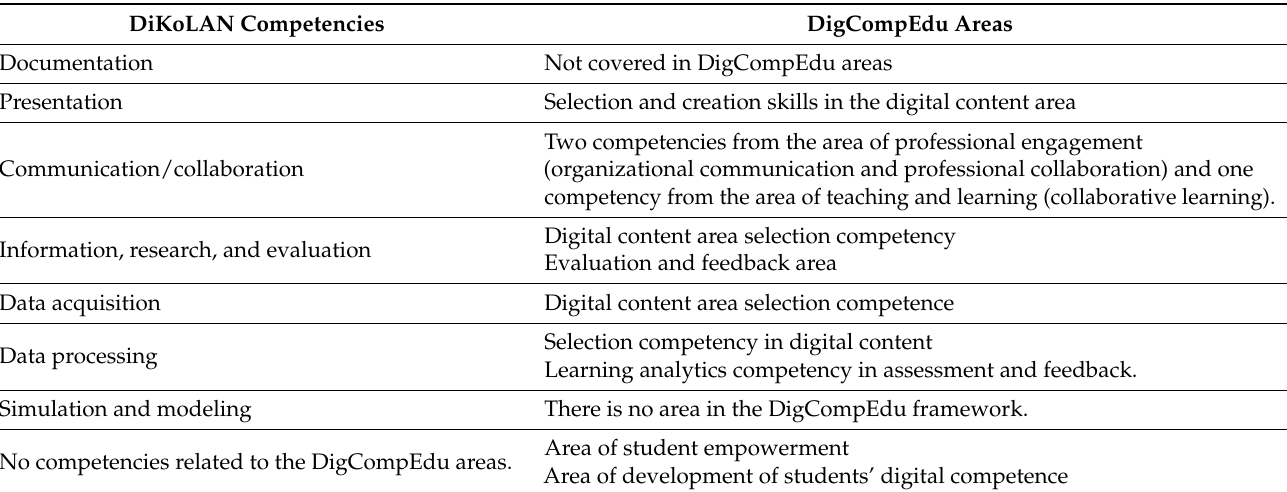
Table 13. Comparison of DiKoLAN and